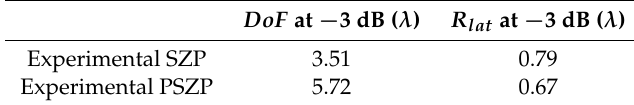
Table 2. DoF at − 3 dB and R lat at − 3 dB, comparison of the experimental